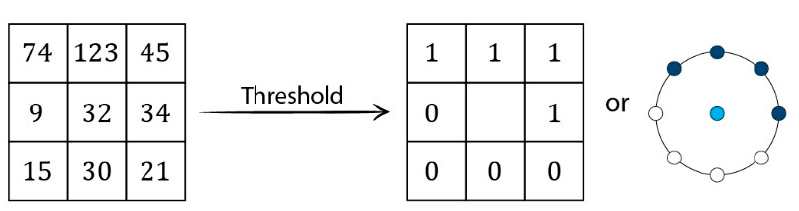
Figure 1. The LBP process where 1’s in the binary code is represented by the bold points on the circle. In total, there are 256 binary codes that one will obtain for any 3-by-3 image patch following the LBP procedure. In [8], Ojala et al. demonstrated that only 58 binary codes out of the 256 were enough to represent 90% of textures in natural images. The 58 binary codes are known as uniform LBP (ULBP) and they experimentally demonstrated that the histogram of ULBP codes can be used as a discriminating feature for computer vision appli- cations [7,9]. ULBP codes encode local texture features such as edges, corners, spots, lines, and flat regions in an image and their binary codes have either 0 or 2 circular transitions from 0 to 1 or from 1 to 0. There are 56 ULBP codes that have two circular transitions and only two ULBP codes with 0 circular transitions in their 8-bit binary representation. 00000000 and 11111111 are the two ULBP codes with 0 transitions. Examples of ULBP codes with two circular transitions are 11000000 and 00111100, whereas a binary code such as 10101010 is not a ULBP because there are more than two circular transitions from 1 to 0 or vice versa. We can group the 56 ULBP codes according to the number of 1’s in their binary representation to form a 7-group geometry G λ for λ = 1, 2, . . . , 7 where λ refers to the number of 1’s in each geometry. Furthermore, each G λ consists of eight binary codes that can be obtained from each other by a circular rotation (see Figure 2). Starting from the top-left corner of the mammograms, we scanned the entire input image by selecting the central pixel value of 3-by-3 patches as landmarks if its binary representation satisfied one of the geometrical circles in Figure 2.